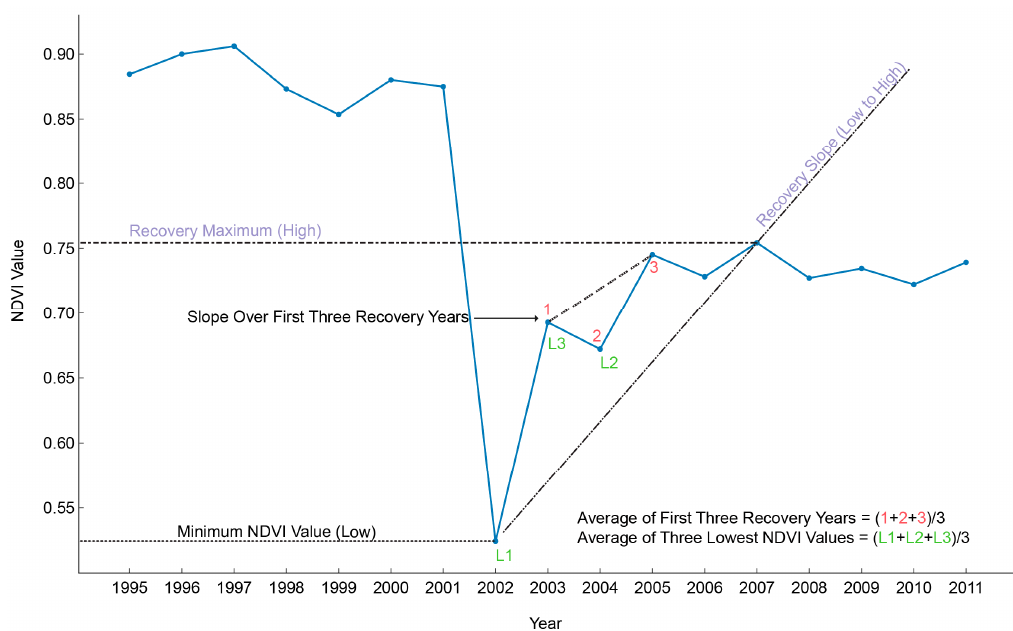
Figure 4. The six predictor variable used in D 3 . The two selected predictor variables from CART ® ( Recovery Maximum and Recovery Slope ) are labeled by violet text (or grey text printed in B&W).